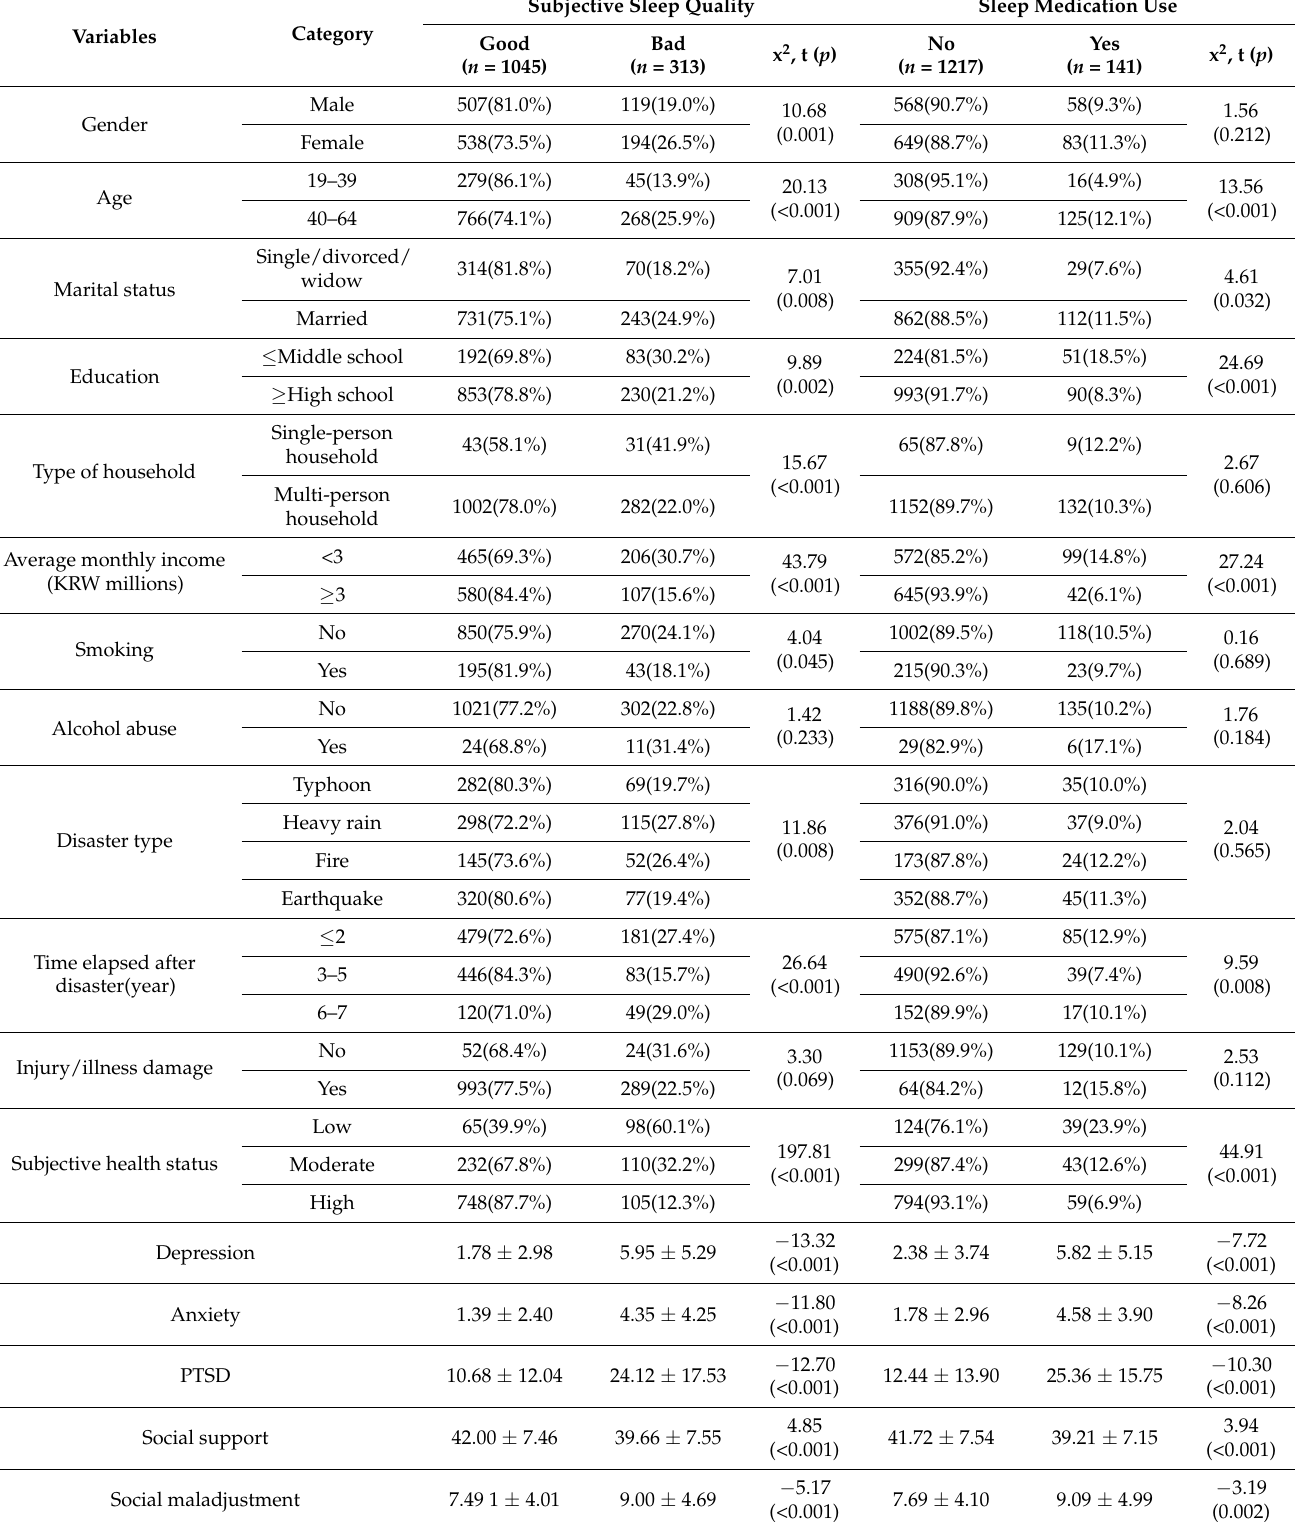
Table 2. Differences in subjective sleep quality and sleep medication use according to participants’ characteristics ( N =